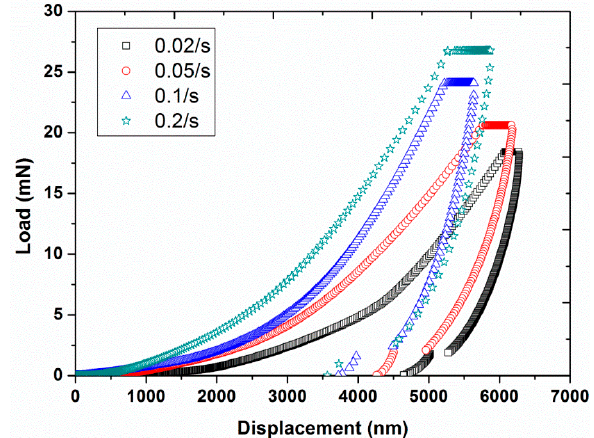
Figure 9. Indentation load as a function of displacement for the four different strain rates (0.02, 0.05, 0.1, and 0.2 s − 1 ) at a frequency of 45 Hz and vibration amplitude of 2 nm. Polymers 2020 , 12 , x FOR PEER REVIEW